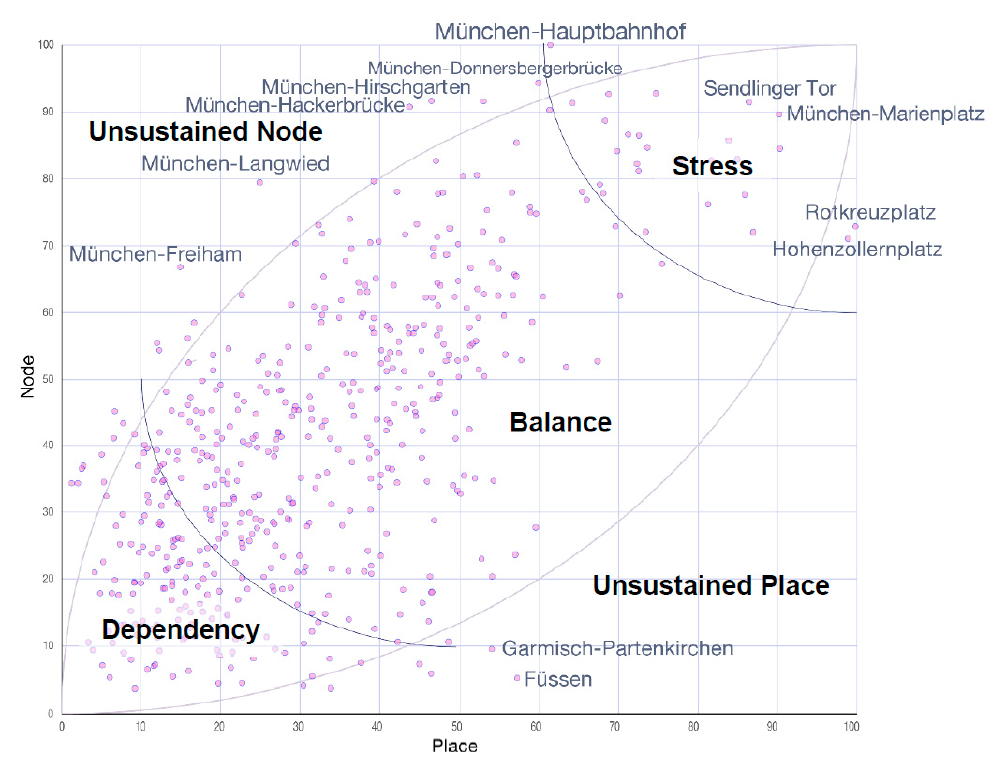
Figure 6. “Node-place diagram” for the Munich metropolitan region in 2019 (Source: own work).